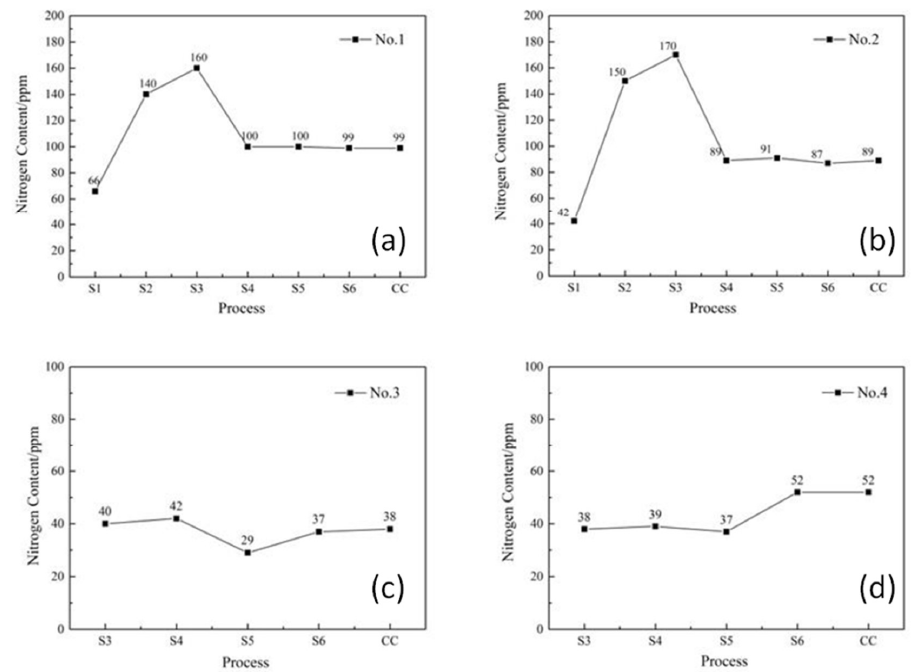
Figure 4. Changes of nitrogen content in steel at each process. ( a ) nitrogen contents of No. 1 heat; ( b ) nitrogen contents of No. 2 heat; ( c ) nitrogen contents of No. 3 heat; ( d ) nitrogen contents of No. 4 heat.